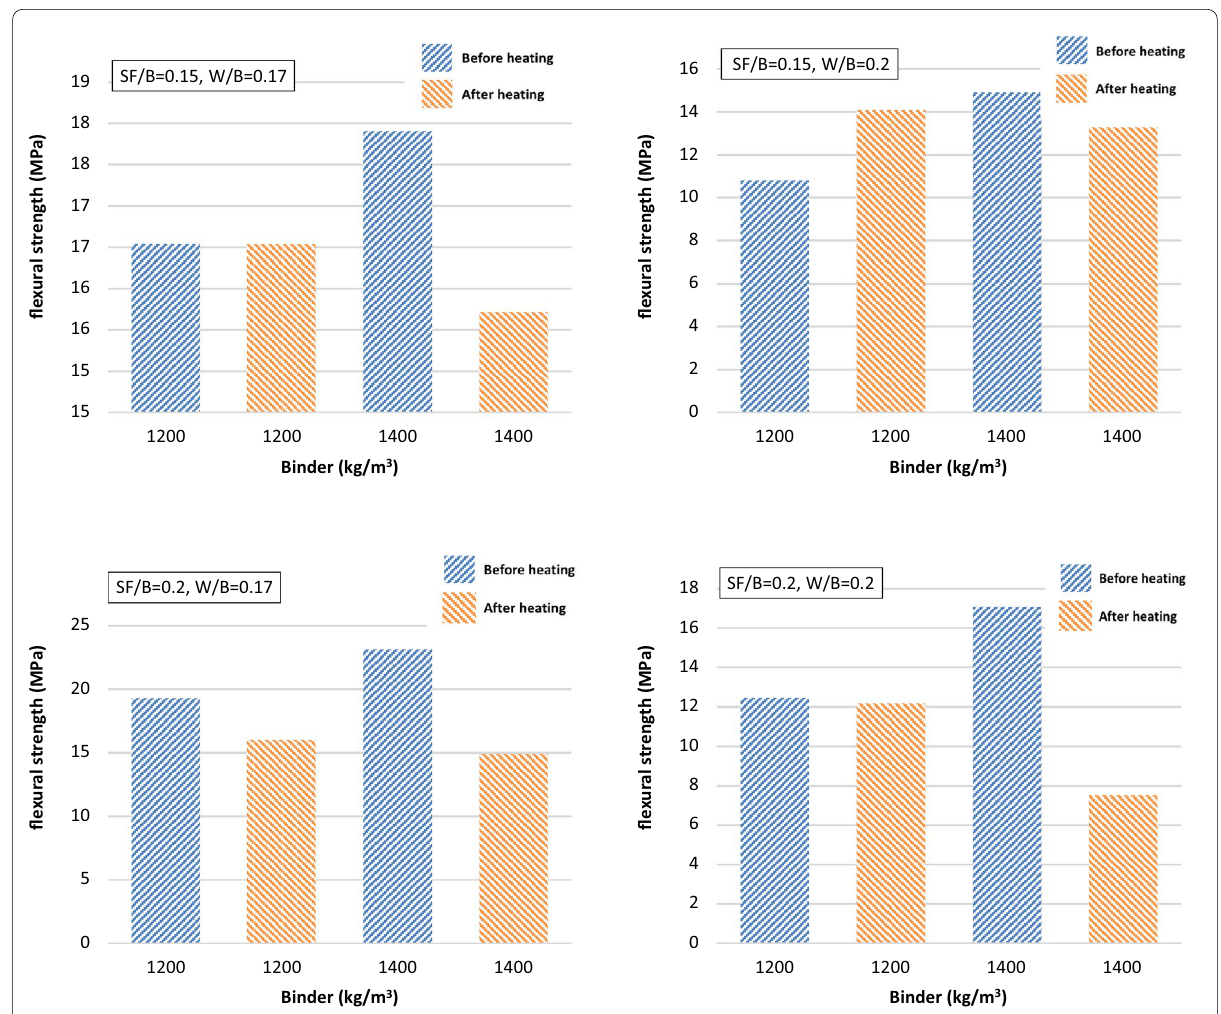
Fig. 10 Variations of flexural strength of concrete mixes against binder content before and after